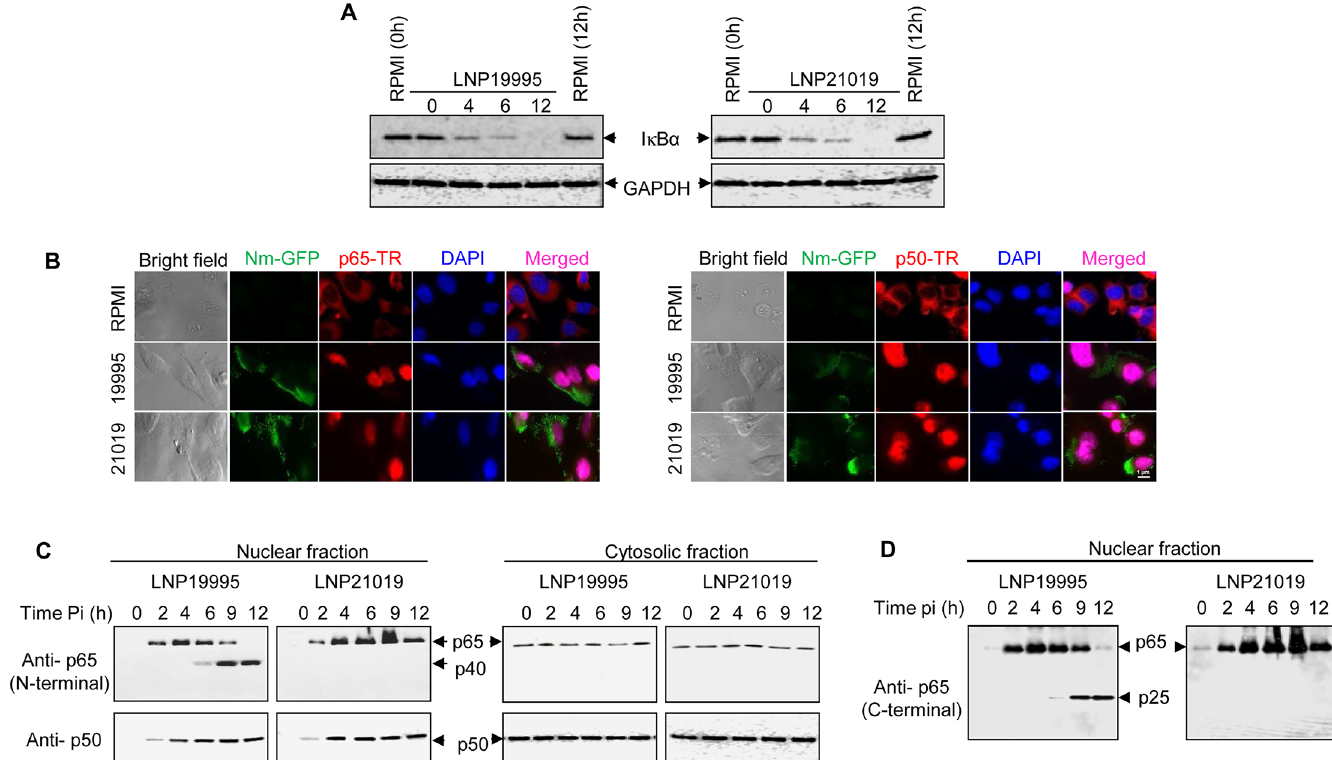
Fig 1. Meningococcal ST-11 isolates promote nuclear cleavage of p65 at late steps of infection. (A) Meningococcal infection is accompanied by IkB α degradation. Hec-1-B epithelial cells were infected with LNP19995 (ST-11) or LNP21019 (non-ST-11) isolates for the indicated time points or left uninfected. Cytosolic fractions were subjected to immunoblotting analysis for I- κ B α . Immunoblotting with anti-GAPDH antibodies was used as a protein loading control. (B) Nuclear translocation of both p65/RelA and p50/NF- κ B1 subunits was not altered by meningococcal infection. Hec-1B cells were infected with GFP- expressing LNP19995 or LNP21019 or left non-infected (RPMI). After 9h, cells were fixed with 3.7% PFA, permeabilised and probed with mouse anti-p65/ RelA mAb (left panel) or rabbit anti-p50/NF- κ B1 (right panel) and Texas red (TR)-conjugated appropriate secondary antibody. Nuclei were stained with DAPI. Fluorescence was analyzed using immuno-fluorescence microscopy. Scale bar (1 μ m) is shown. Data are representative of three independent experiments. (C) Nuclear or cytosolic fractions from (A) were analysed by immunoblotting using anti-N-terminal p65/RelA specific mAb (upper panels) or anti-p50/NF- κ B1 rabbit polyclonal antibody (lower panels). Shown is a representative blot of three independent experiments. p65/RelA cleavage product p40 is indicated by arrows. (D) The blot of nuclear fractions from (C) was stripped and probed against a goat polyclonal antibody directed against C-terminal region of p65/RelA. The cleavage product p25 is indicated by